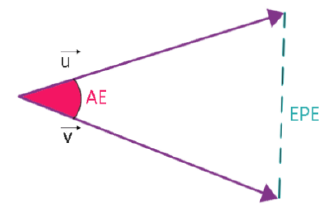
Figure 6. Difference between AE and EPE.